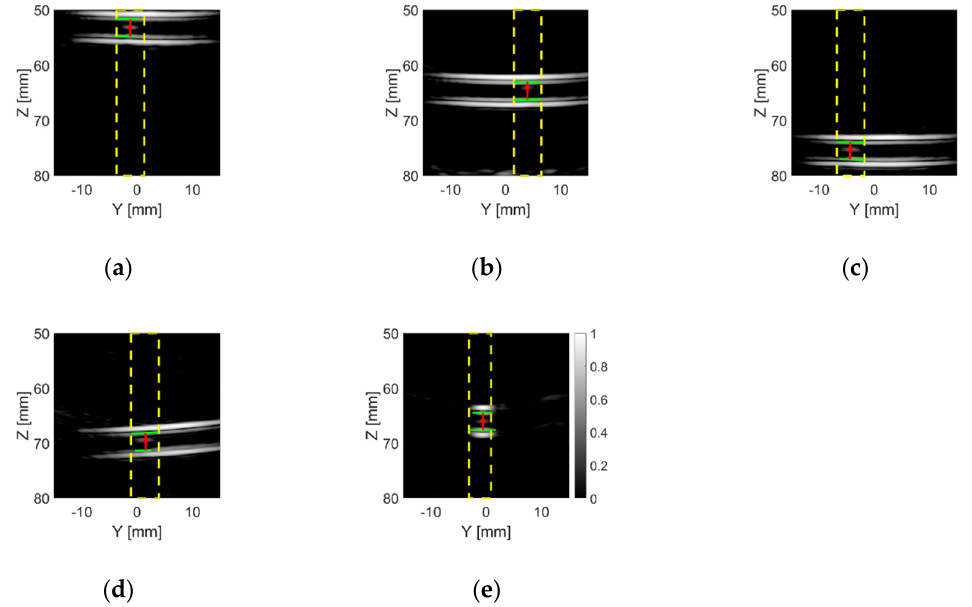
Figure 17. The results after applying the particle detection algorithm to the frames which were converted from the example TFM images of ( a ) the 55 mm phantom, ( b ) the 65 mm phantom, ( c ) the 75 mm phantom, ( d ) the Angle V phantom and ( e ) the Angle H phantom with the TMM particle placed inside the tube from the CECAT. The dashed yellow lines indicate the regions in which a particle was detected. The solid red lines represent the distance from the particles (red dots) to the top and bottom inner walls of the tube (solid green lines). Table 6. Results of applying the particle estimation algorithms to TFM images shown in Figure 17.